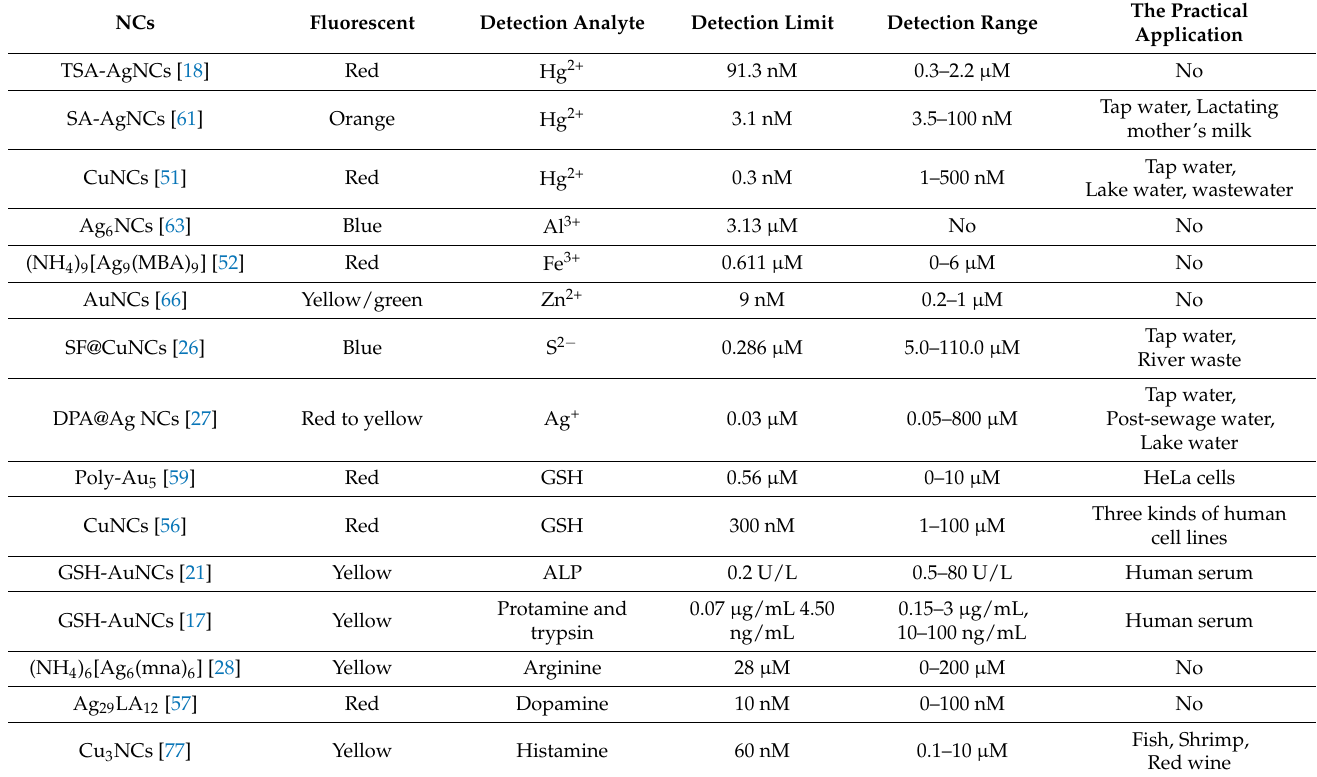
Table 2. Comparison of the analytical performances of assembled NCs